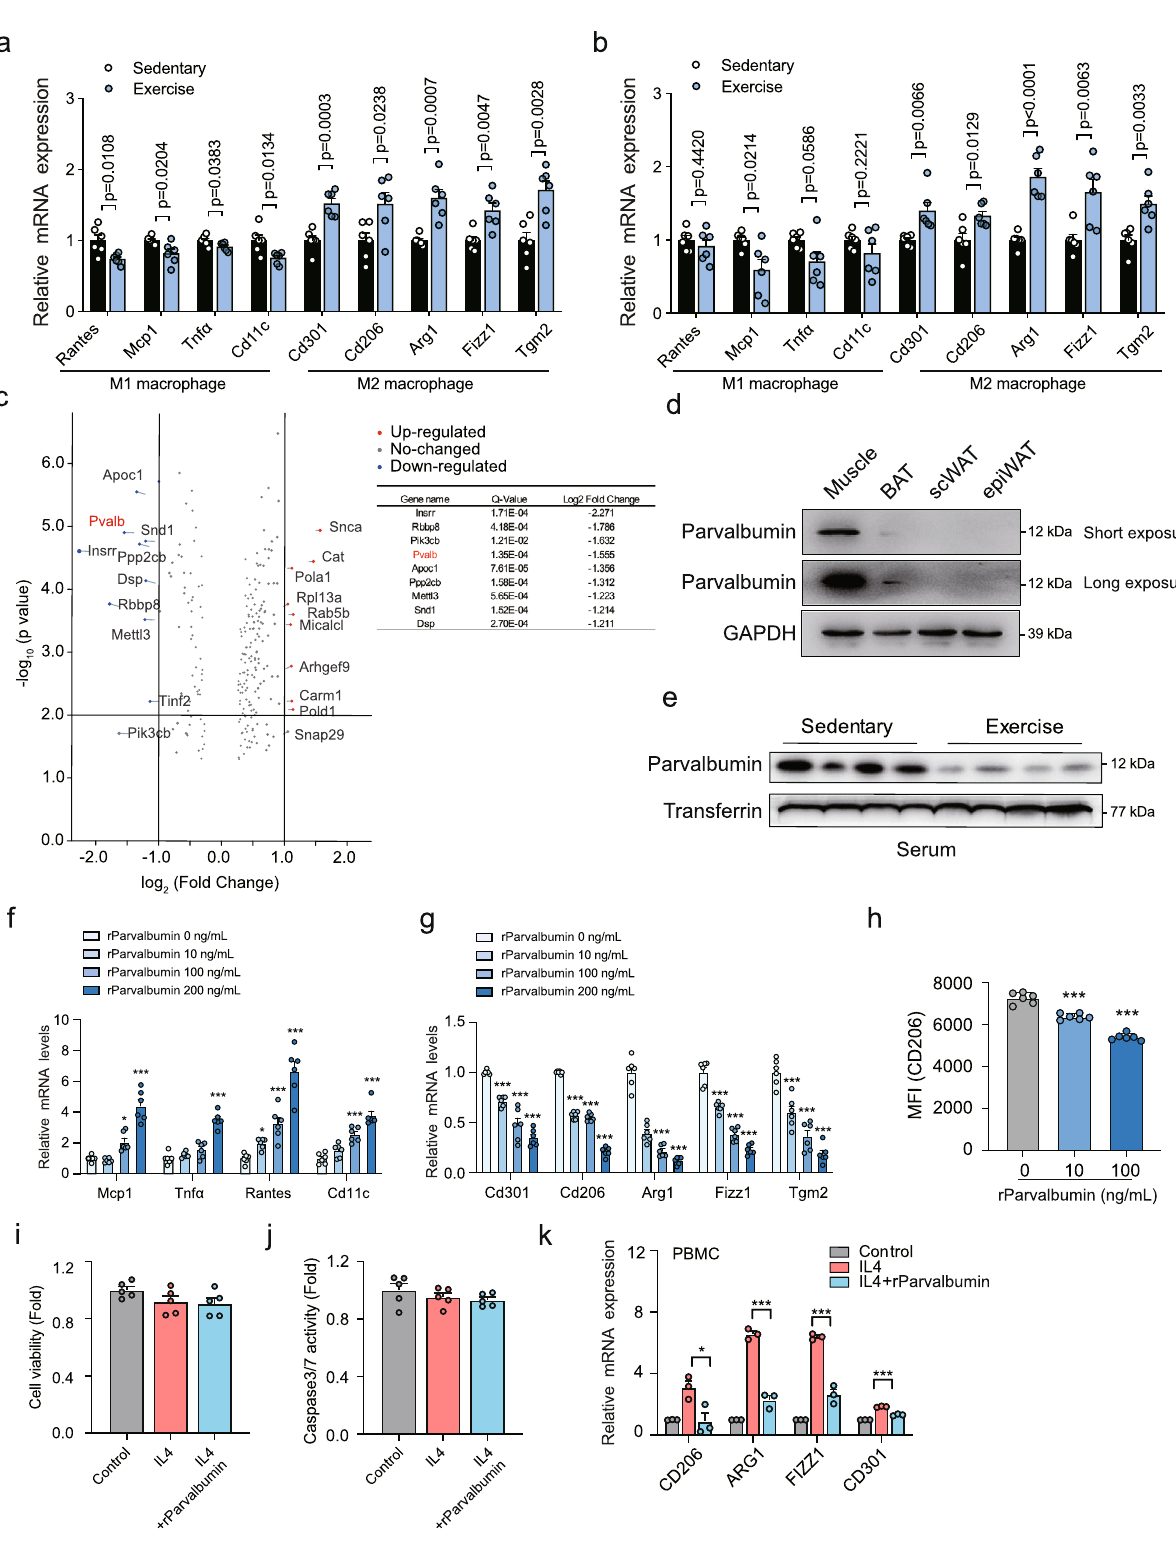
(Fig. 1i, j). Furthermore, to gain insight into whether parvalbumin may inhibit markers of M2 macrophages in humans, we obtained human PBMCs from 4 healthy humans and found that recombinant human parvalbumin (100 ng/ml) inhibited IL4- induced M2 macrophage marker expression in these cells (Fig. 1k).